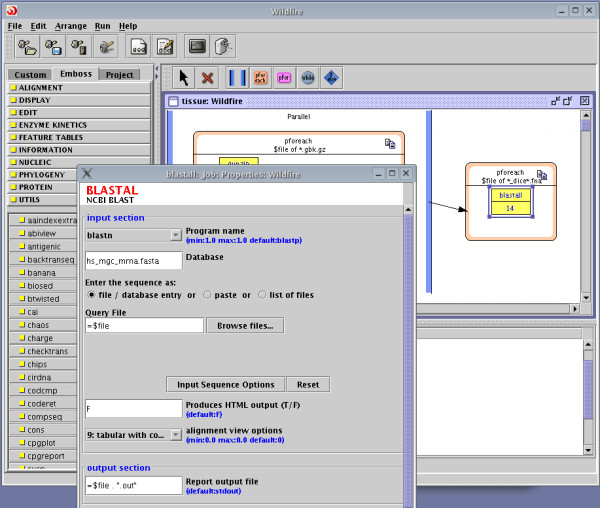
Elements of the Wildfire interface. The main window in the background shows the workflow canvas. Its left panel lists the atomic workflow components; this list is preconfigured with all EMBOSS applications and can be customised. The foreground window shows the properties form for the blastall program.